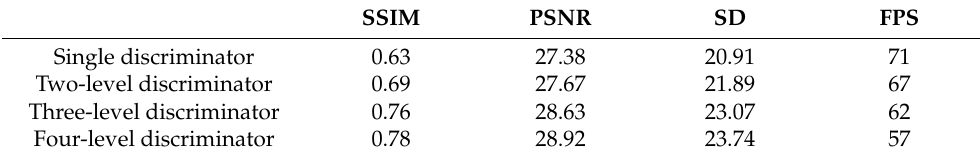
Table 8. A comparison of the validity of discriminatory